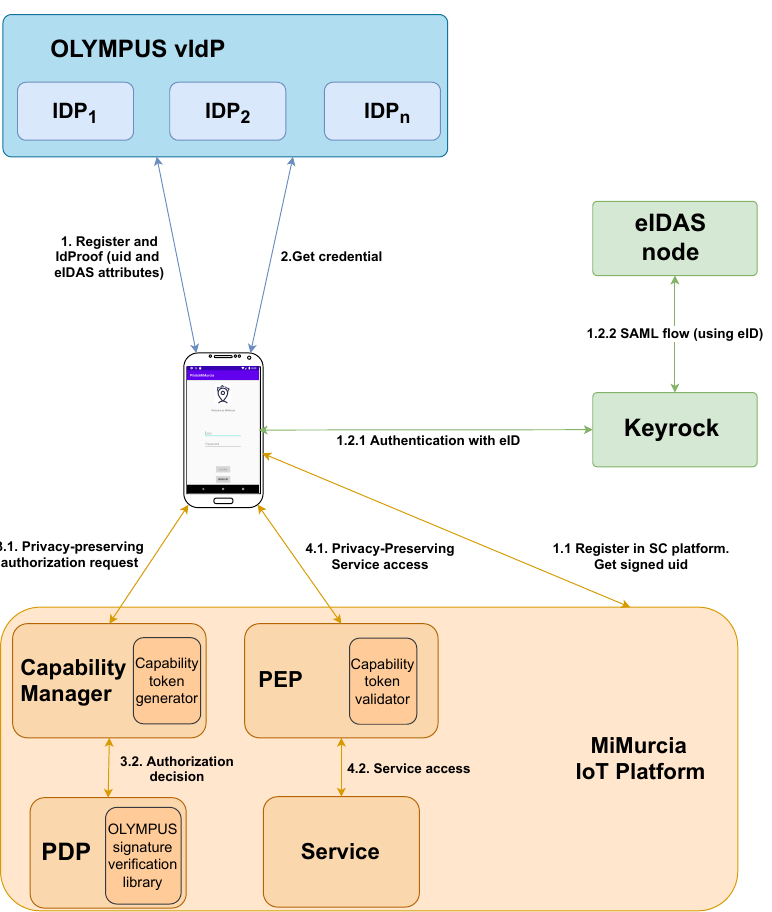
Figure 4. MiMurcia IoT Platform: Components and Flow.